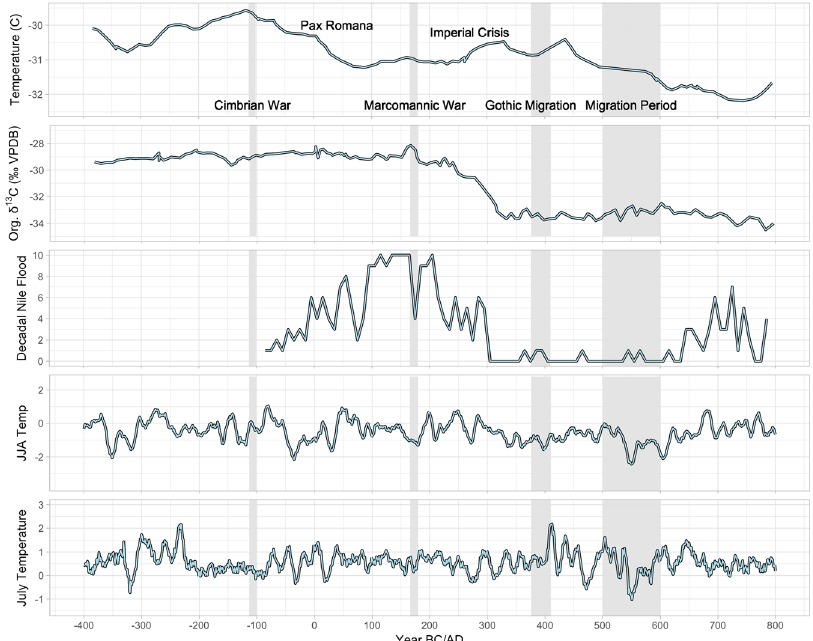
Figure 4. GISP2 Northern Hemisphere Temperature Reconstruction 40 , stable carbon isotope ratios as a